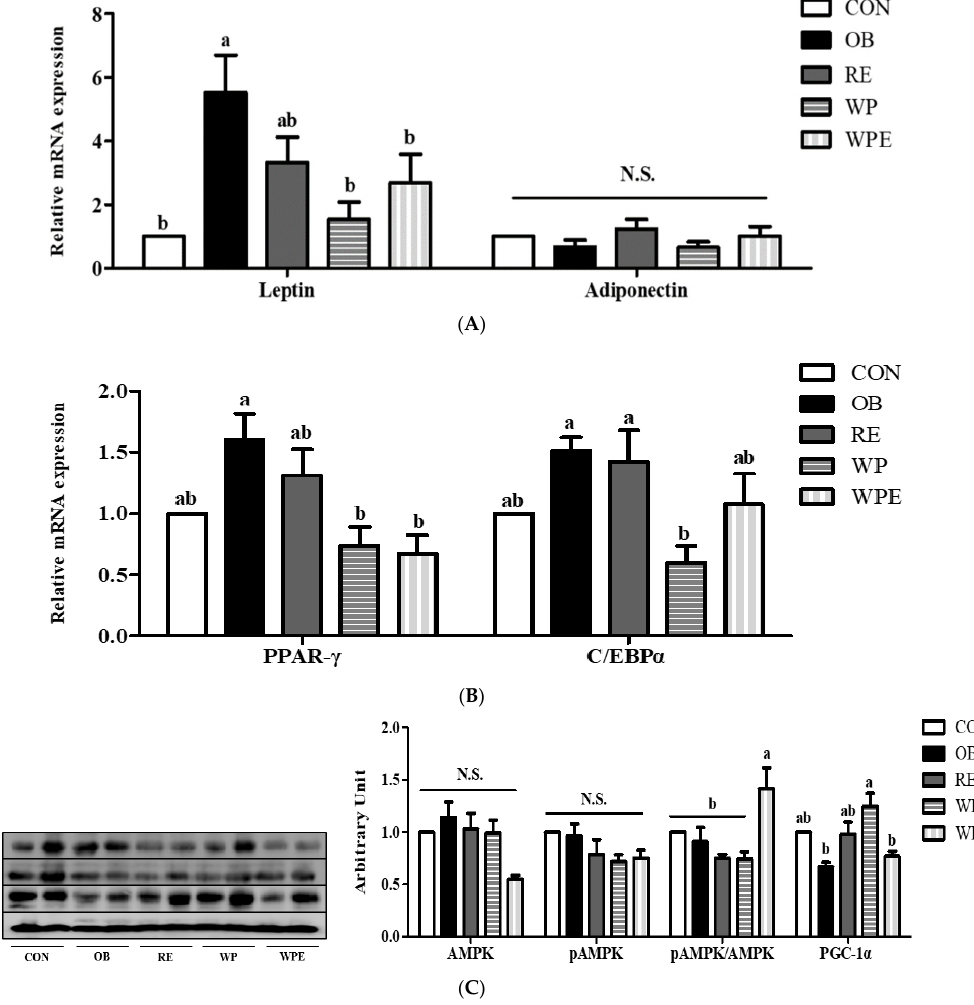
Figure 4. Effects of WP supplementation and RE on adipose tissue adipokines, lipid and energy metabolism in sarcopenic obese mice. ( A ) Adipokines ( B ) Lipid metabolism, and ( C ) Energy metabolism. Values are means ± SEMs, n = 6–8. Mean values with the same superscript letter (a and b) are not significantly different ( p < 0.05). PPAR- γ , peroxisome proliferator-activated receptors γ ; C/EBP α , CCAAT-enhancer-binding proteins α ; AMPK, AMP-activated protein kinase; PGC-1 α